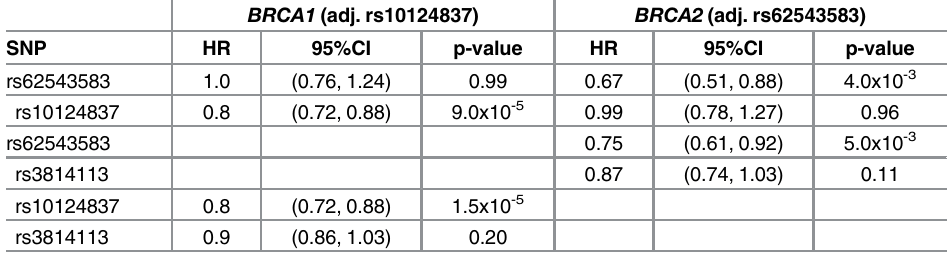
Table 3. Conditional associations for BRCA1 and BRCA2 top SNPs. The table shows the HR estimate. 95% CI and p-value for the conditional analysis adjusting for the lead SNP in the univariate analysis for BRCA1 (left hand side) or BRCA2 mutation carriers (right had side). SNPs correspond to: rs10124837, the strongest associated in BRCA1 ; rs62543583, the strongest associated in BRCA2 mutation carriers; rs7046326, the strongest associated in BRCA1/2 meta-analysis; rs3814113, was the strongest associated variant in the initial GWAS analysis. “ HR ” , hazard ratio; “ CI ” , confidence interval. BRCA1 (adj.